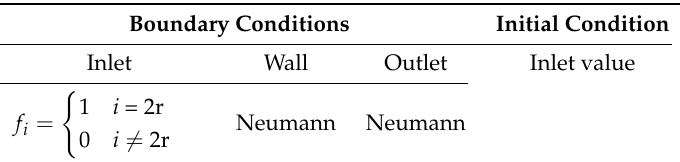
Table 6. Boundary and initial condition for f i